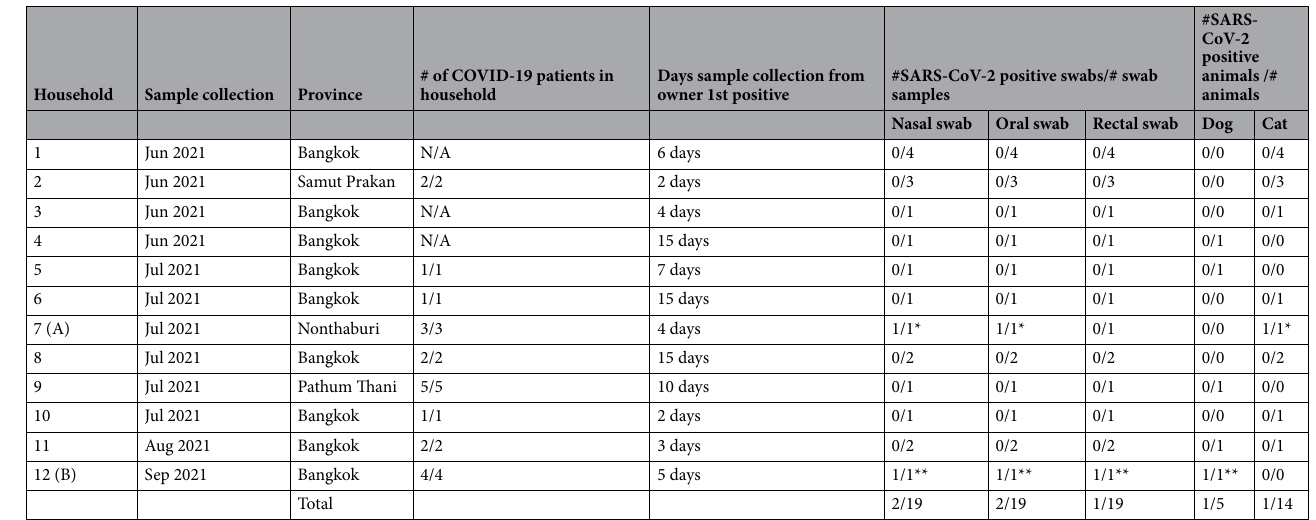
Table 2. List of COVID-19 positive households where dogs and cats were sampled and tested for SARS- CoV-2. *SARS-CoV-2 positive from household A; July 15, 2021. **SARS-CoV-2 positive from household B; September, 12,